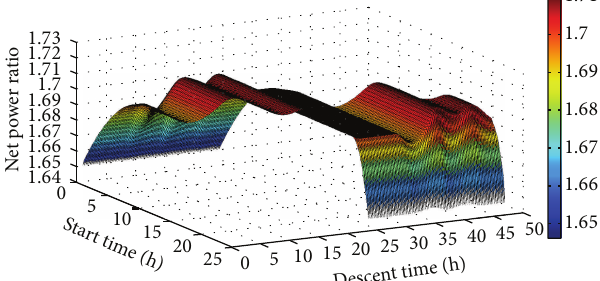
Figure 6: Trend of the power ratio with respect to the start time of the cruise and descent phases.